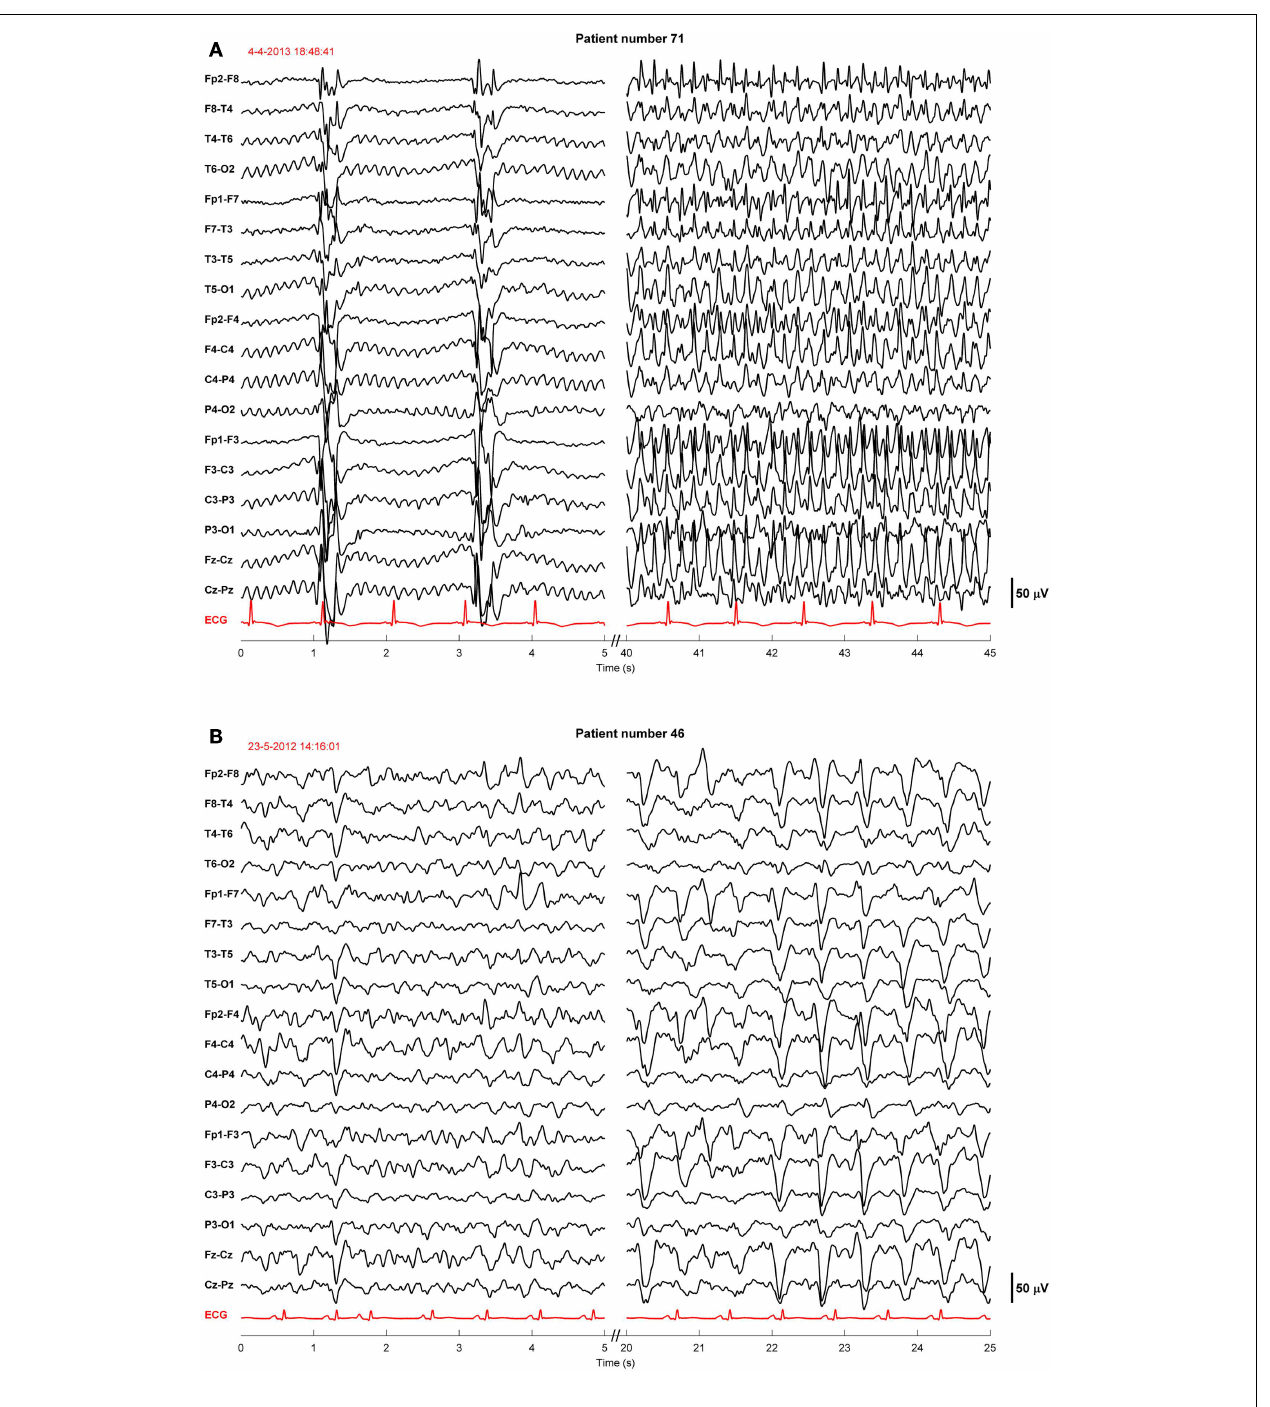
FIGURE 3 | Examples of EEGs of two comatose patients after cardiac arrest showing evolving seizures .These patients were sedated with propofol 1–2.5mg/kg/h.The EEG epochs were recorded 19h after cardiac